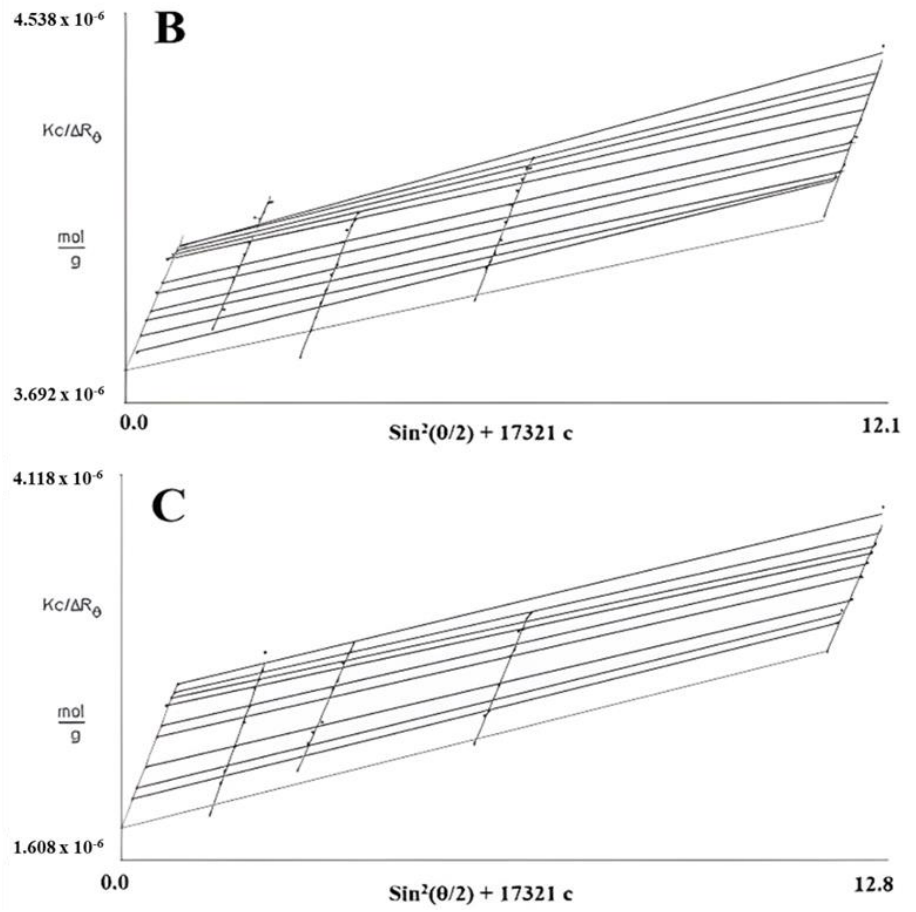
Figure 4. Zimm plots of flaxseed mucilage RG-I (FM-R) in 0.5 M NaOH ( A ), and flaxseed kernel RG-I (FK-R) in 0.5 M NaOH ( B ) or 6 M NH 4 OH ( C ) determined by static light scattering (at various solution concentrations, 23 °C).